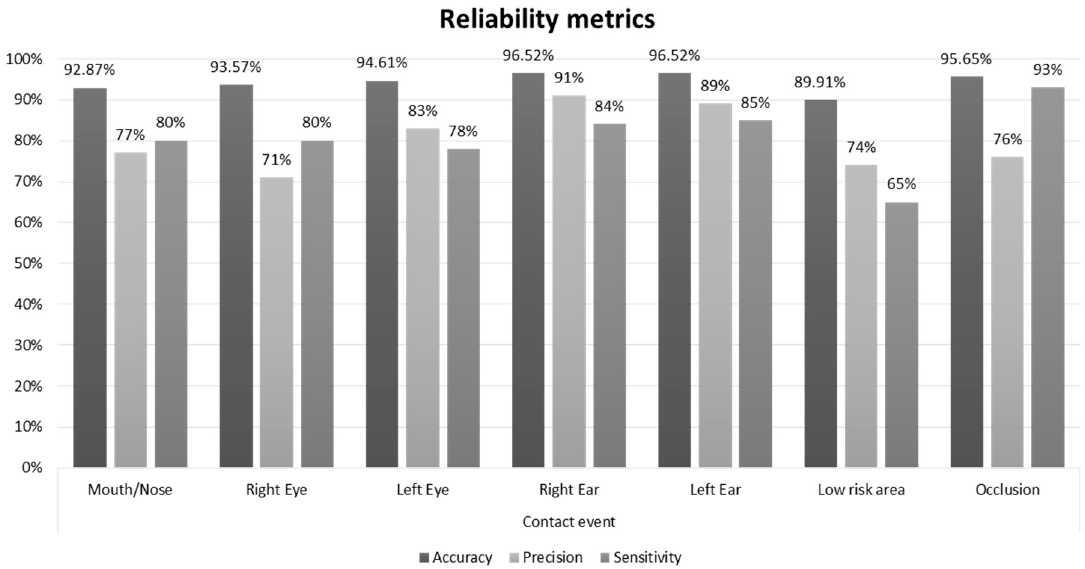
Table 1. The confusion matrix for the seven-class classification.